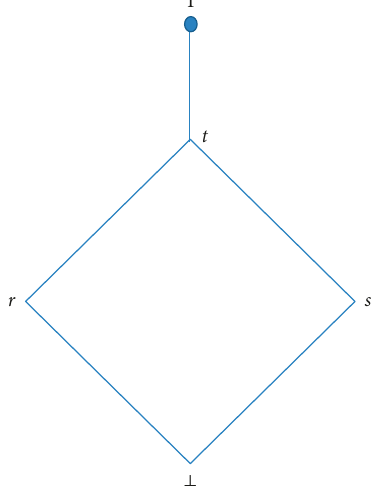
Figure 4: Illustration of M.